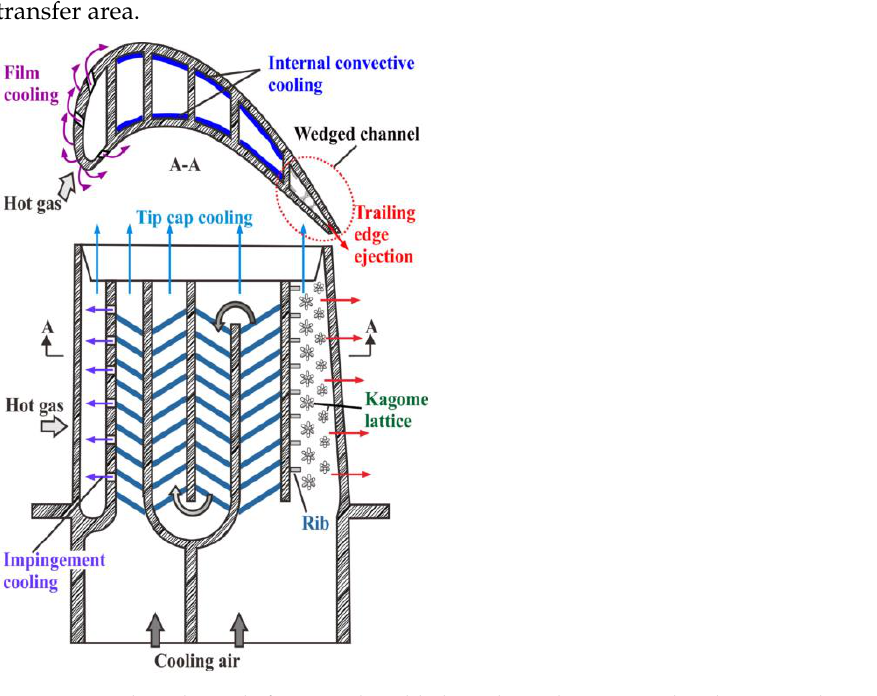
Table 1. Literature on different applications of porous/lattice structures in aerospace field.